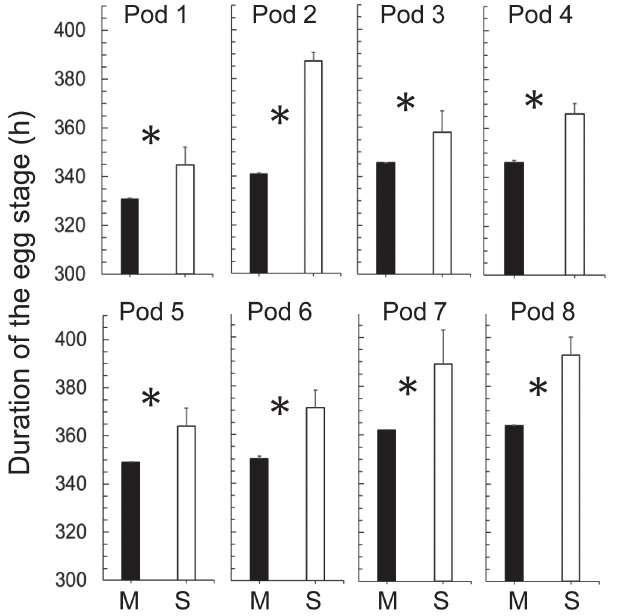
Fig. 3. The effect of egg separation on embryogenesis in Locusta migratoria at 30°C. The times (mean ± SD) required to hatch for Locusta migratoria eggs kept as a mass (closed bars) or as separated eggs (open bars) at 30°C. Asterisks indicate a significant difference between the 2 treatments at the 5% level with a t-test. Error bars indicate SD. n = 13–20 each.